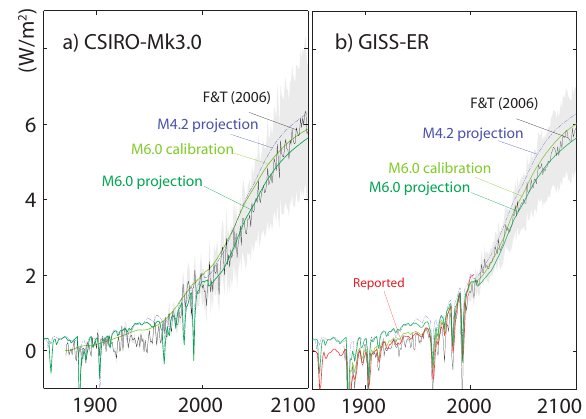
Fig. 2. Effective radiative forcing for the SRES A1B scenario from 1850 to 2100 for two CMIP3 AOGCMs. Shown are the net effec- tive radiative forcing time-series used for calibrating MAGICC6 to CSIRO-Mk3.0 (a) and GISS-ER (b) (“M6.0 calibration”). Due to various unification adjustments and complementation of the sparse AOGCM-specific forcing sets, the effective forcings prescribed for the projections differ. Shown here is the mean for each AOGCM when combined with the ten C 4 MIP carbon cycle model calibra- tions (“M6.0 projection”). For comparison, the forcings used in IPCC AR4 for the medium carbon cycle feedback case (“M4.2 pro- jection”) and the effective forcings (including uncertainties) as di- agnosed by Forster and Taylor (2006) (’F&T, 2006’) are also shown. In addition, in the case of the GISS-ER model, radiative forc- ing time series were made available by the modeling group (“Re- ported”) (J. Hansen, personal communication, 2005, as reported in Forster and Taylor,